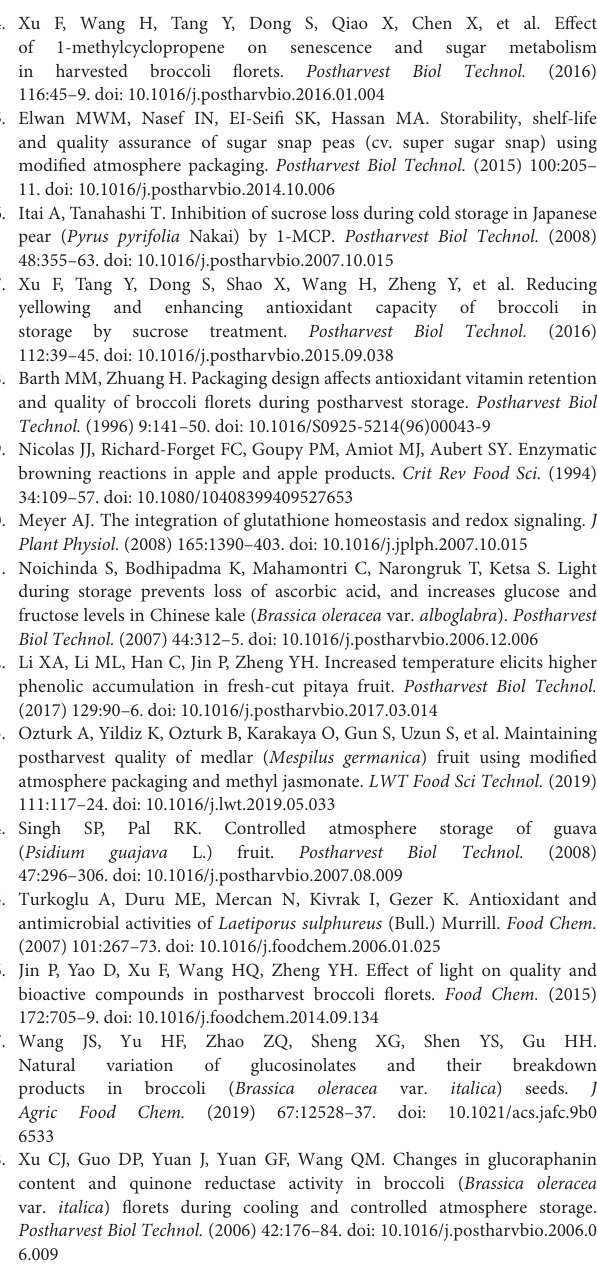
Supplementary Table 1 | Sensory and nutritional qualities in the lateral buds of baby mustard during